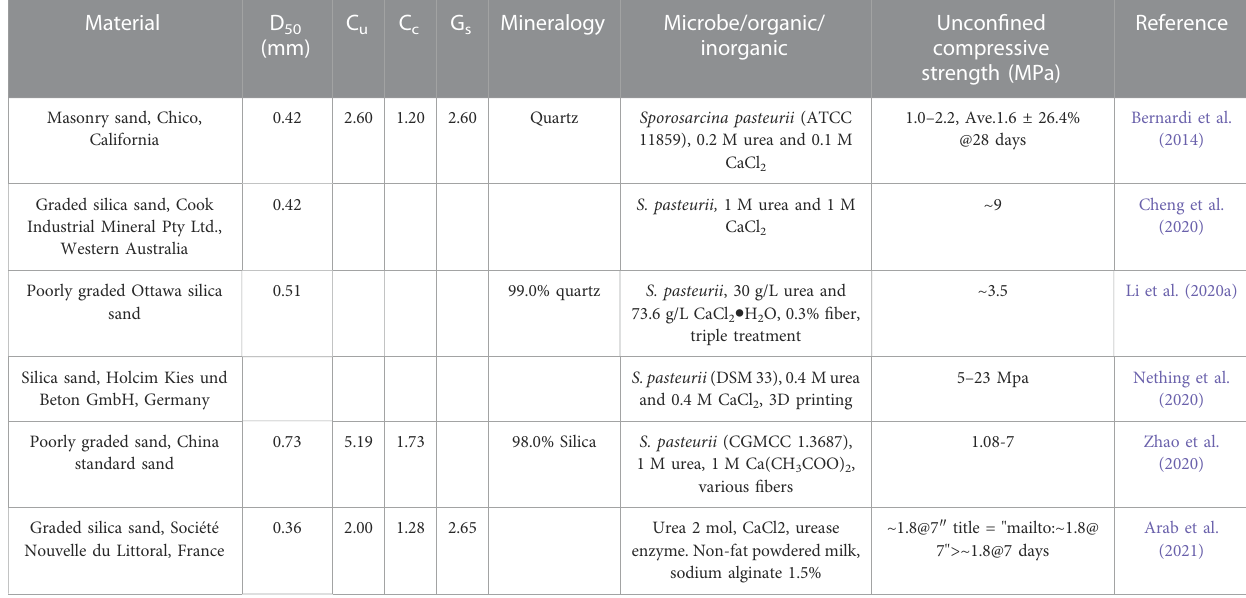
TABLE 2 From sand to arti fi cially “ bio-bricks ” and comparable uncon fi ned compressive strength.